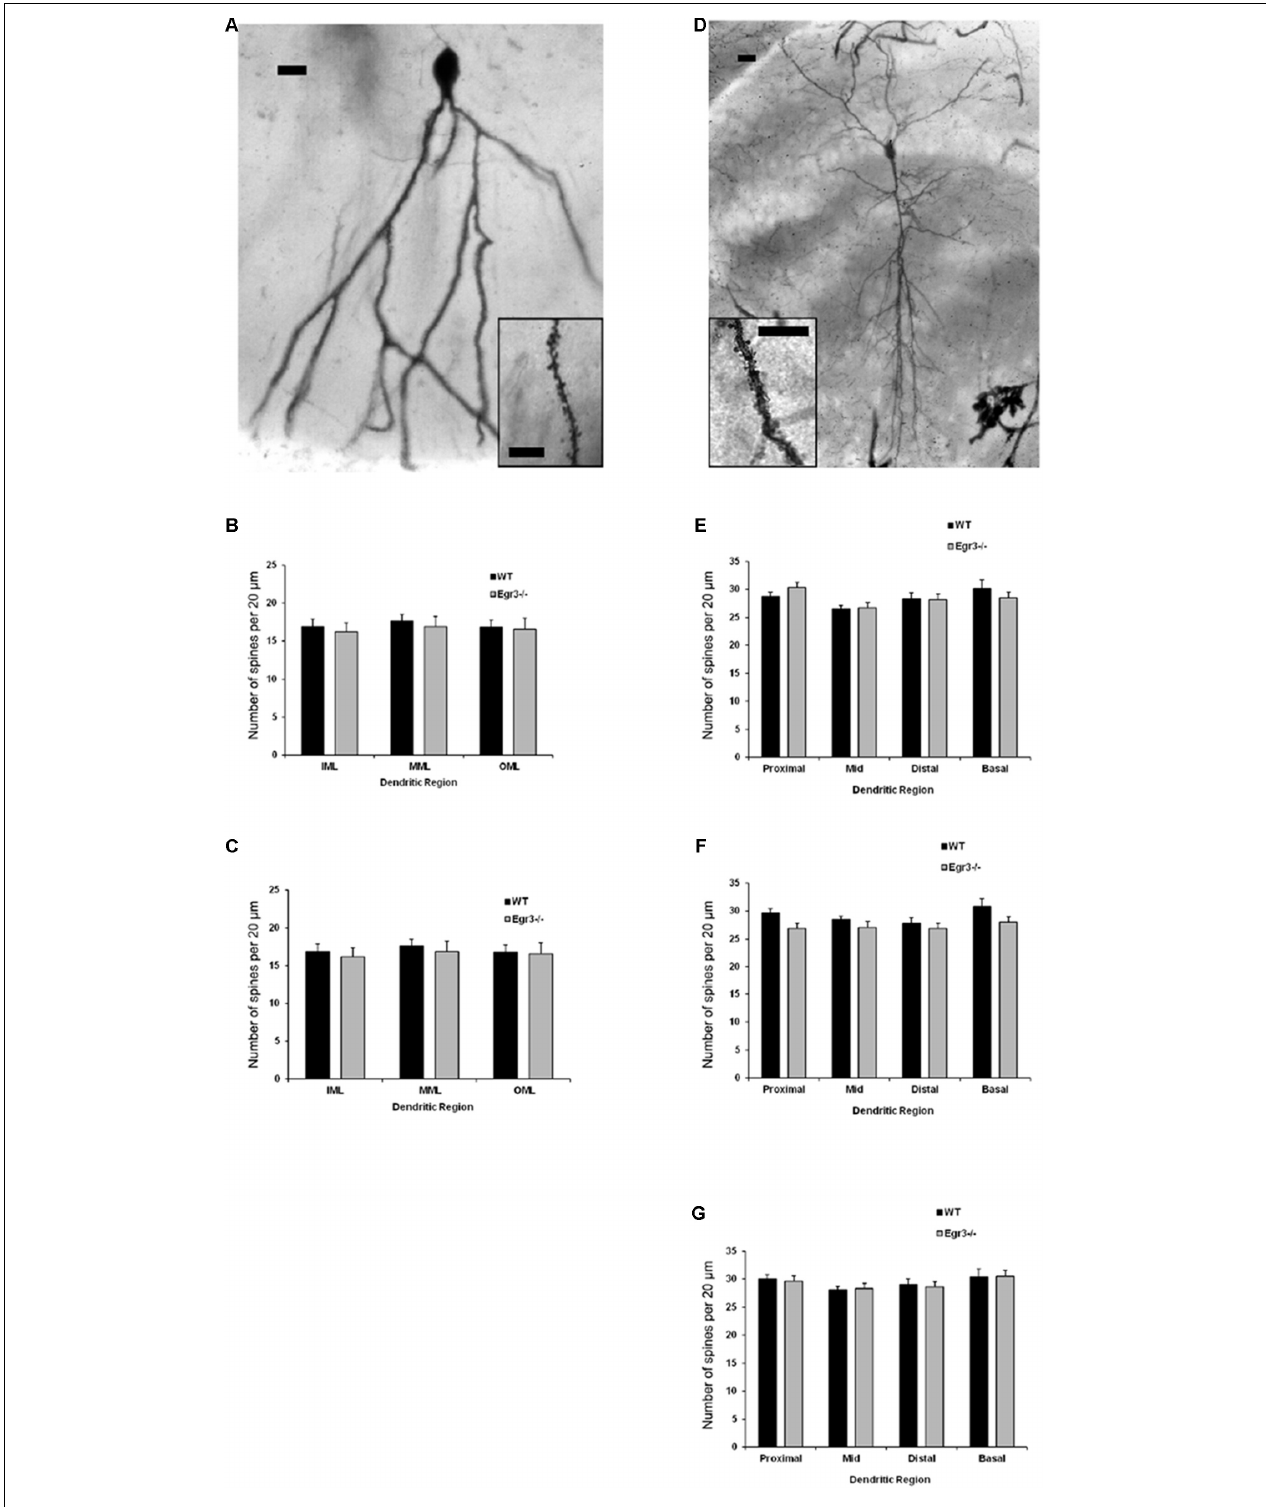
FIGURE 6 | Egr3 is not required for normal development of neuronal morphology. Samples of Golgi-Cox staining in (A) granule cells and (D) pyramidal cells shows impregnation of both gross dendritic structure (scale bar = 20 µ m) as well as spines (inset, scale bar = 10 µ m). Quantitative data show no statistically significant differences in either dendritic morphology or spine number between WT (black) and Egr3 –/– (gray) mice in the (B) DG sp , (C) DG ip , (E) CA1, (F) CA3a/b, or (G) CA3c regions.